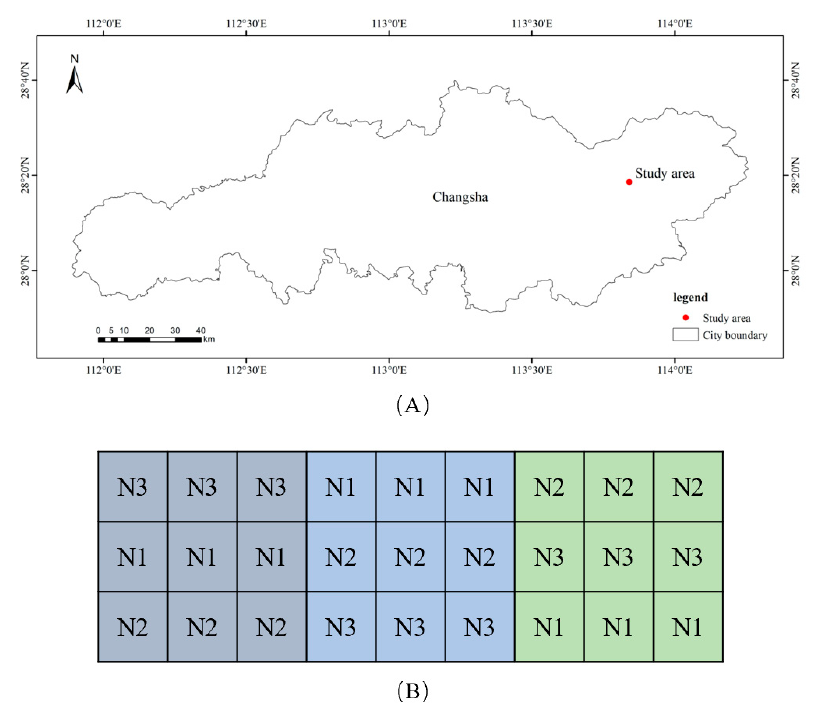
Table 1. Basic information of fertilizer treatment in the study area.